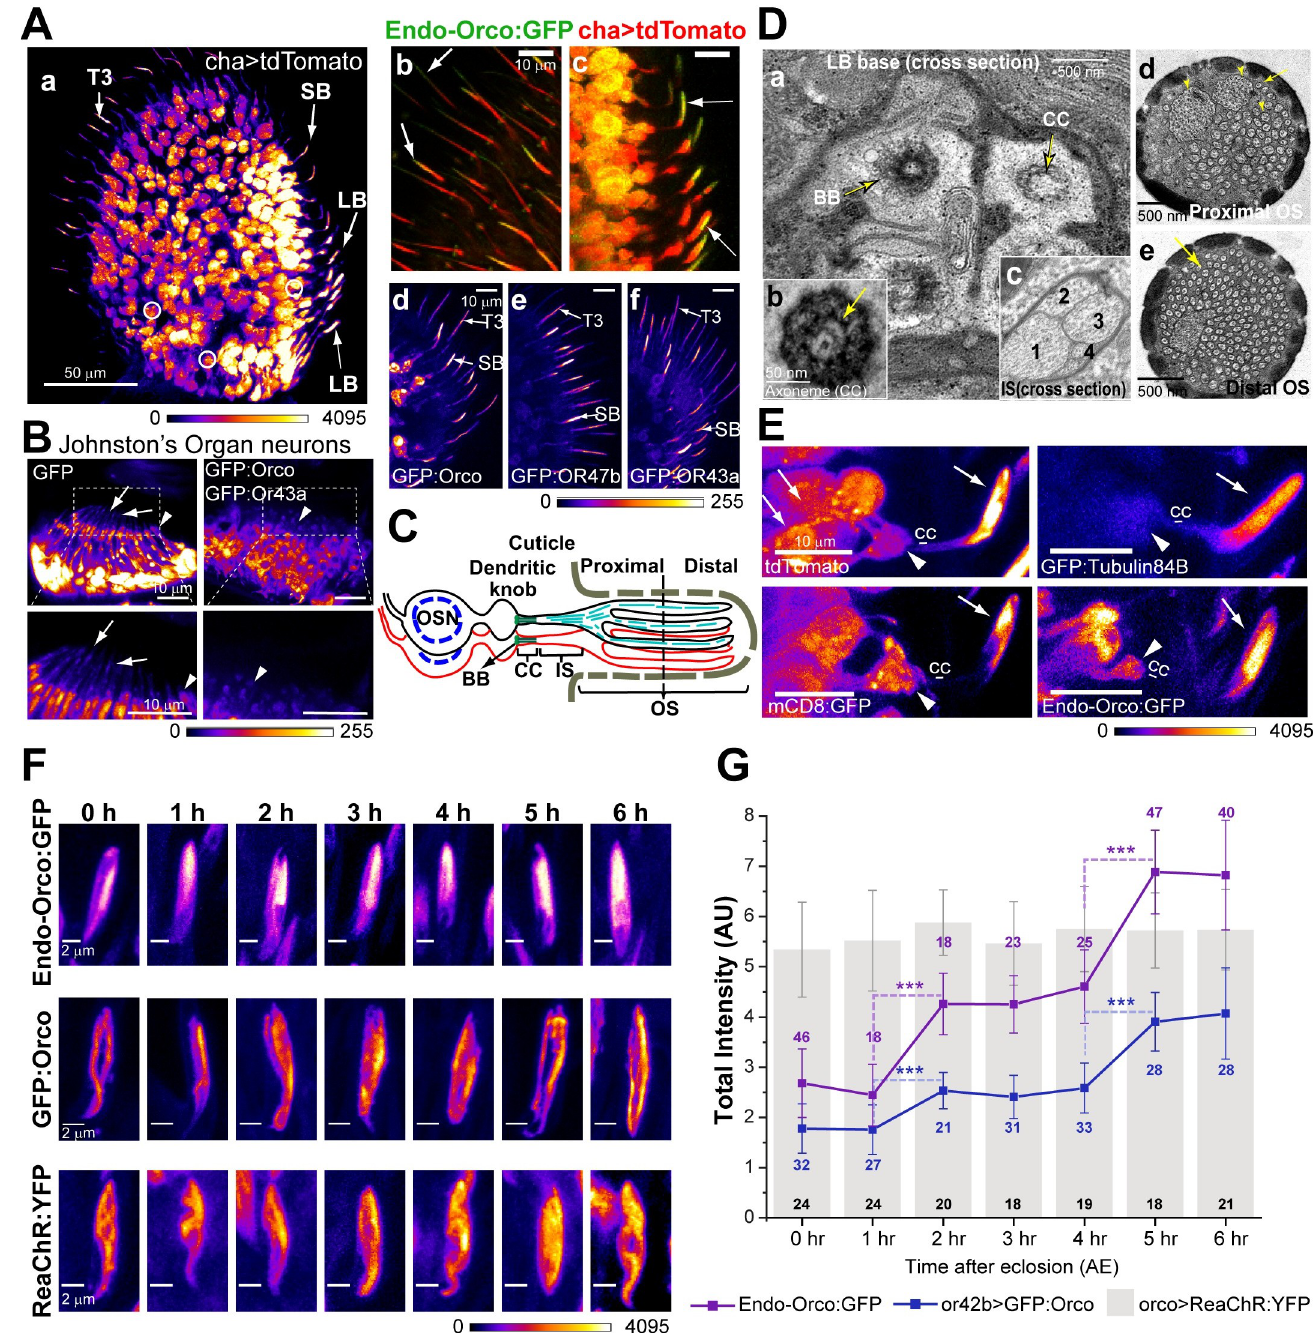
Fig 1. The developmental profile of Orco localisation in the cilia. (A) Organization of olfactory sensory neurons (OSNs) in the adult third antennal segment marked by chaGal4 > UAS-tdTomato (a), and enlarged views of the s . trichodea (b) and s . basiconica (c) regions expressing both Endo-Orco:GFP ( orco fTRG ) and chaGal4 > UAS-tdTomato . A few OSN cell bodies are circled white, and the labelled arrows indicate cilia inside small and large s . basiconica (SB and LB type) and s . trichodea (T3 type) shafts. Ectopic expressions of GFP:Orco (d), GFP:Or47b (e), and GFP:Or43a (f), respectively, by the chaGal4 , marked the cilia (arrows) inside all SB and T3-type sensilla. (B) Chordotonal neurons of the Johnston’s organ expressing soluble GFP and GFP:Orco along with GFP:Or43a, respectively, by chaGal4 . Arrowheads mark the dendritic knobs, and arrows mark the cilia region. (C) Schematic illustrates cilia organisation on OSNs innervating s . basiconica . (D) TEM images of transverse sections through the base of an LB-type sensillum show the basal bodies (BB) and the connecting cilium (CC) of four innervating cilia (a). Each connecting cilium (CC) carries nine doublet microtubule (9+0) bearing axoneme (arrow, b). Sections of the inner segment (IS, c) and outer segment (OS, d, e) shows the arrangement of singlet microtubules within a membrane sleeve (yellow arrow). (E) tdTomato, GFP:Tubulin84B, mCD8:GFP and Endo-Orco: GFP localisations in the cilia inside ab1-type s . basiconica (arrows- ciliary OS, and arrowheads- ciliary base). (F) Endo-Orco:GFP and the recombinant bacterial